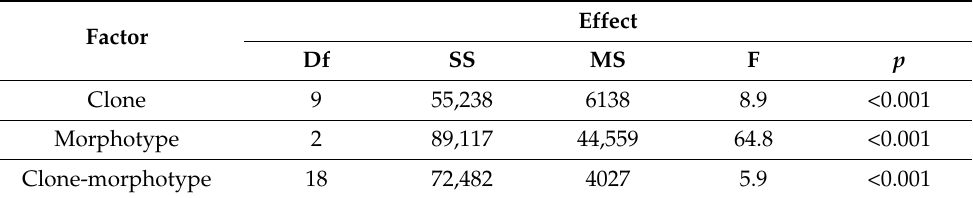
Table 3. The results of the two-way variant analysis (F-test) of the influences of the clones and summer morphotypes on the number of Metopolophium dirhodum (Walk.) (June